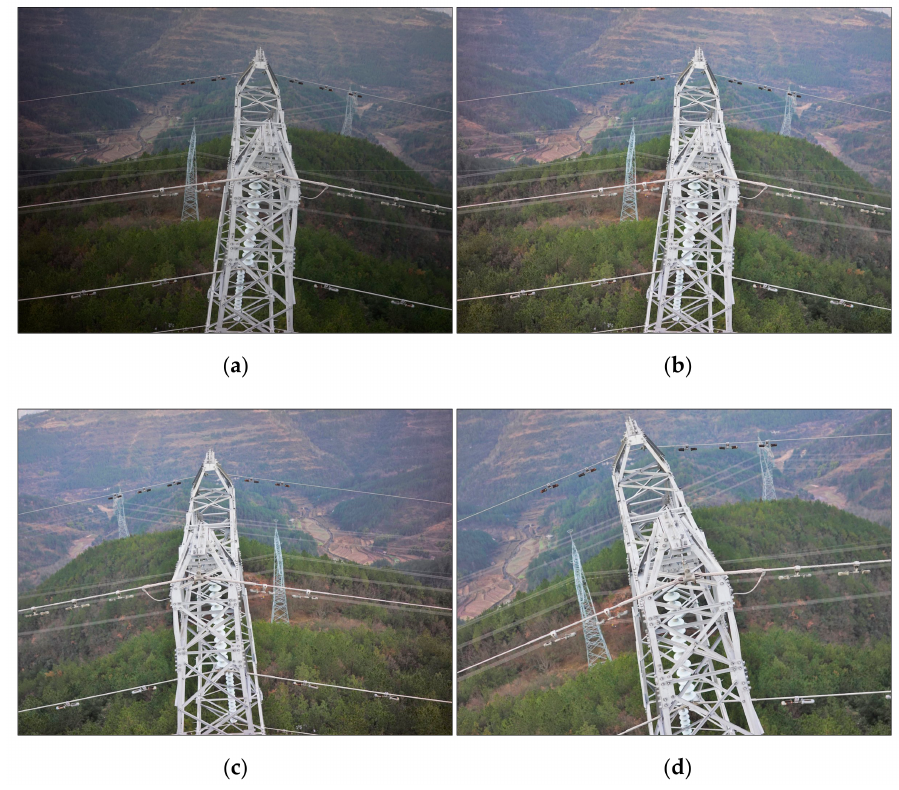
Figure 6. Examples of preprocessed UAV remote sensing images: ( a ) original image; ( b ) gamma correction and MSR; ( c ) horizontal flip; ( d ) 15 ◦